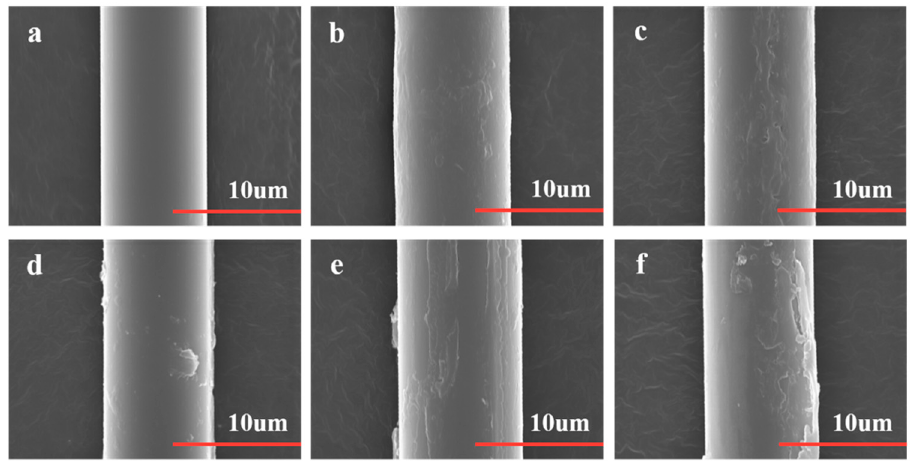
Figure 1. SEM images of ( a ) BF—Desized, ( b ) BF-PVP, ( c ) BF-PEN, ( d ) BF-PPEK, ( e ) BF-PPEN and ( f ) BF-PPENK.